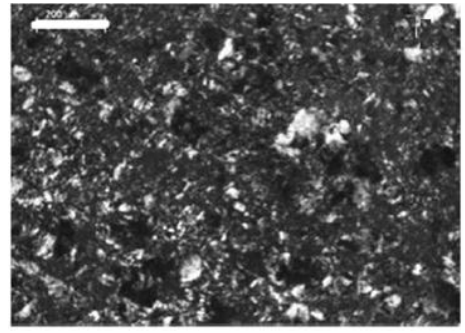
Figure 7. Optical polarizing microscopy of a nematic phase obtained by concentrating 2.05 wt% ss-DNA/CNT complexes, at 25.0 °C, upon adding 1.54 wt% dextran sulfate and separating the two phases. Bar size is 200